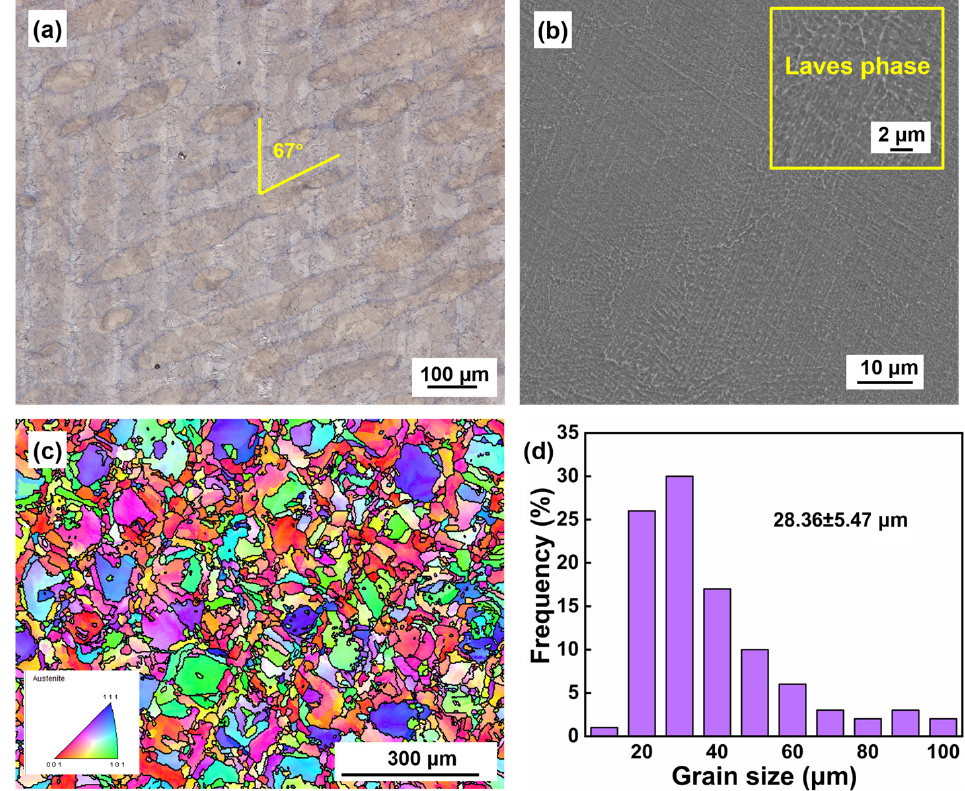
Figure 8. The microstructure of DA samples in X-Y direction: ( a ) OM morphologies, ( b ) SEM image, ( c ) An EBSD inverse-pole figure (IPF) map, ( d ) Grain size distributions.